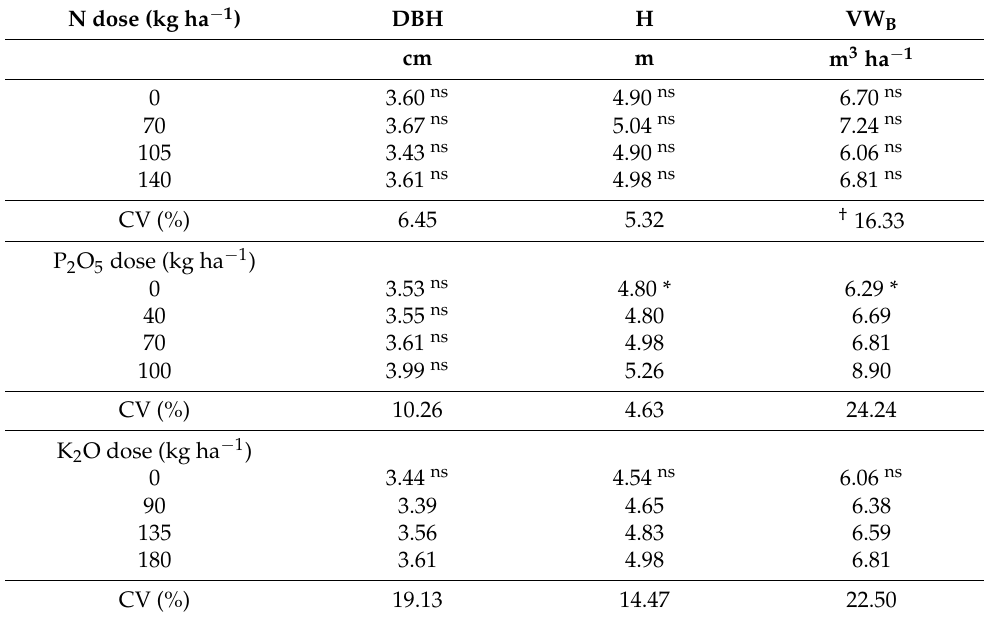
Table 7. Initial growth of eucalyptus after five months of eucalyptus shoot sprouting, diameter at breast height (DBH), plant height (H) and total wood volume (VW B ) as a function of residual dose of N, P 2 O 5 and K 2 O.